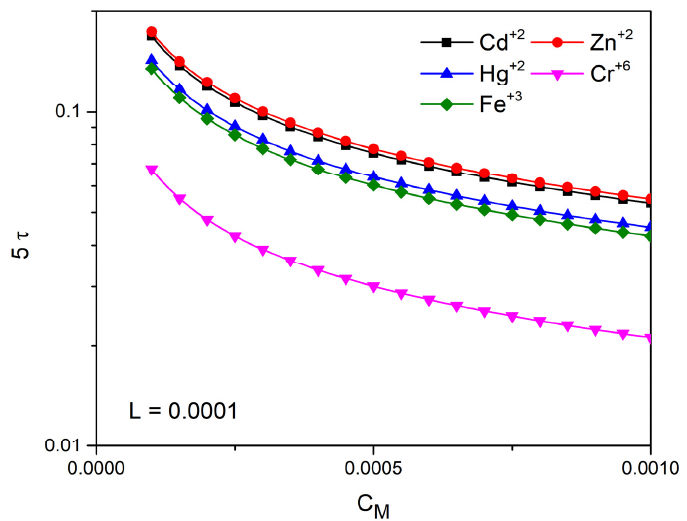
Figure 9. 5 τ (s) as a function of C M ( mol / m 3 ) for ions with z = 2 (Cd +2 , Zn +2 , Hg +2 ) and z = 3 (Fe +3 ) Figure 9. 5 τ (s) as a function of 𝐶 (cid:3014) (mol m (cid:2871) (cid:3415) ) for ions with z = 2 (Cd +2 , Zn +2 , Hg +2 ) and z = 3 (Fe +3 ) and (mol z=6 (Cr +6 ) for L = 0.0001 m. and z=6 (Cr +6 ) for L = 0.0001 m. Figure 9. 5 τ (s) as a function of 𝐶 (cid:3014) m (cid:2871) (cid:3415) ) for ions with z = 2 (Cd +2 , Zn +2 , Hg +2 ) and z = 3 (Fe +3 ) and z=6 (Cr +6 ) for L = 0.0001 m.